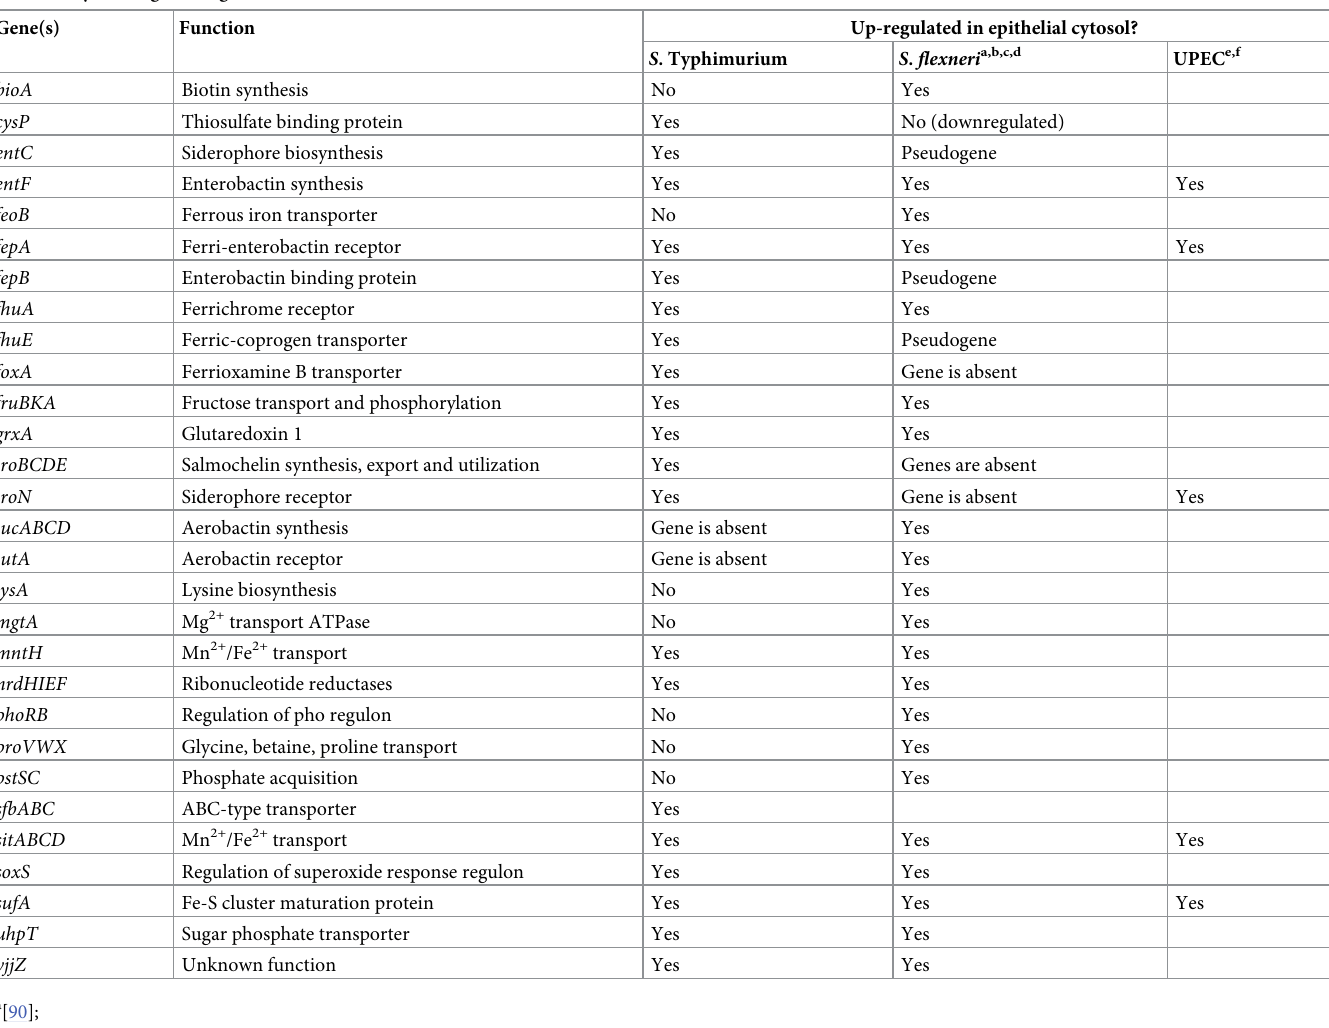
Table 1. Cytosol signature